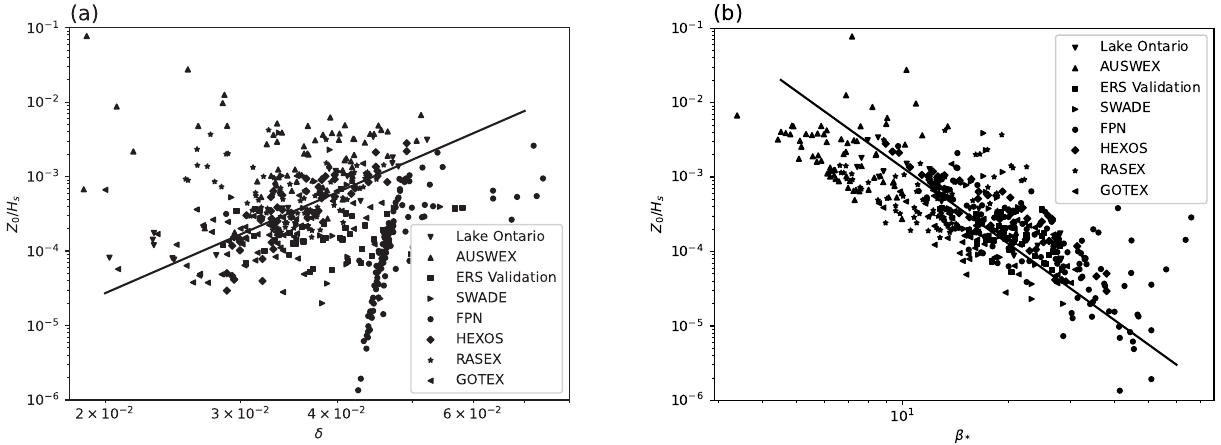
Figure 1. Dimensionless roughness z 0 / H s vs. ( a ) wave steepness δ and ( b ) wave age β ∗ for data points from eight datasets. The solid lines represent the curves of TY01 and DN03 in ( a , b ), respectively.